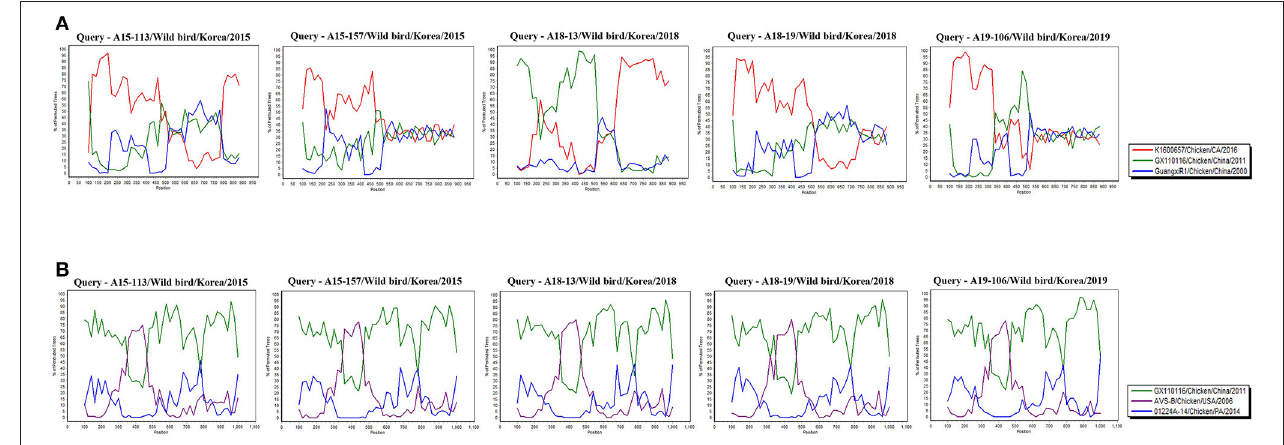
FIGURE 5 | Bootscan analysis of wild bird ARV for detecting recombination was performed using Simplot program version 3.5.1, the neighbor-joining method with a Kimura 2-parameter applied and 100 replicates. (A) σ C-encoding gene, (B) σ NS-encoding gene.